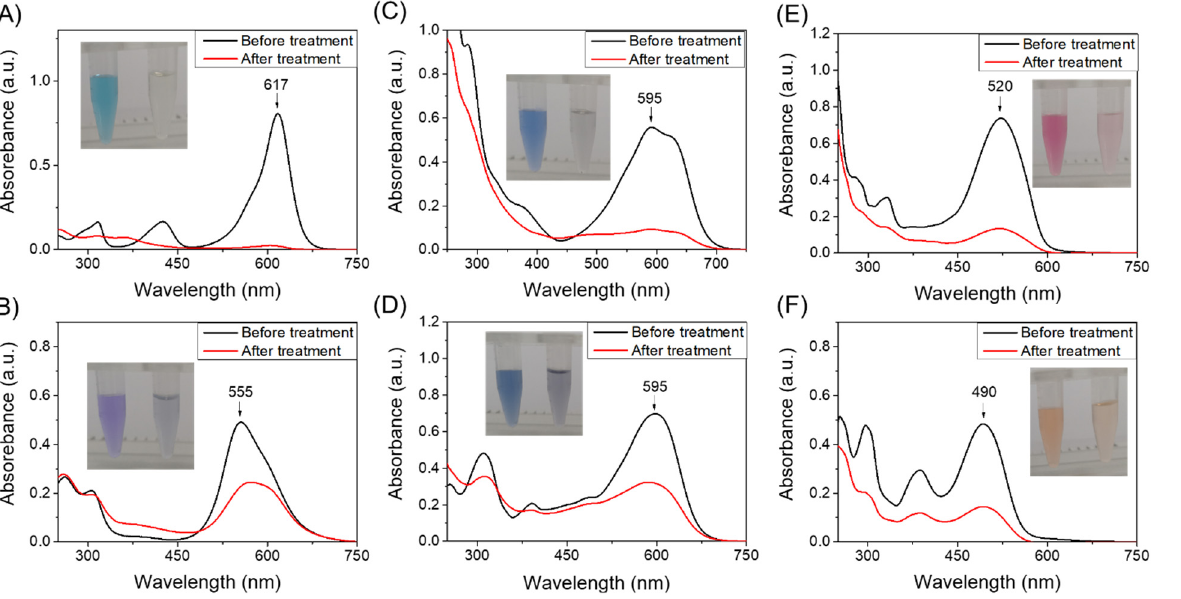
Figure 3. UV–vis absorption spectra of organic dyes before and after treatment by F43Y/T67R/P88W/F138W Mb (5 μ M) in the presence of H 2 O 2 (5 mM): ( A ) Malachite Green Oxalate F43Y/T67R/P88W/F138W Mb (5 µ M) in the presence of H 2 O 2 (5 mM): ( A ) Malachite Green Oxalate (5 μ M), ( B ) Brilliant blue R (20 μ M), ( C ) Reactive blue 19 (60 μ M), ( D ) Reactive black 5 (20 μ M), ( E ) (5 µ M), ( B ) Brilliant blue R (20 µ M), ( C ) Reactive blue 19 (60 µ M), ( D ) Reactive black 5 (20 µ M), Amaranth (20 μ M), and ( F ) Reactive orange 16 (20 μ M). ( E ) Amaranth (20 µ M), and ( F ) Reactive orange 16 (20 µ